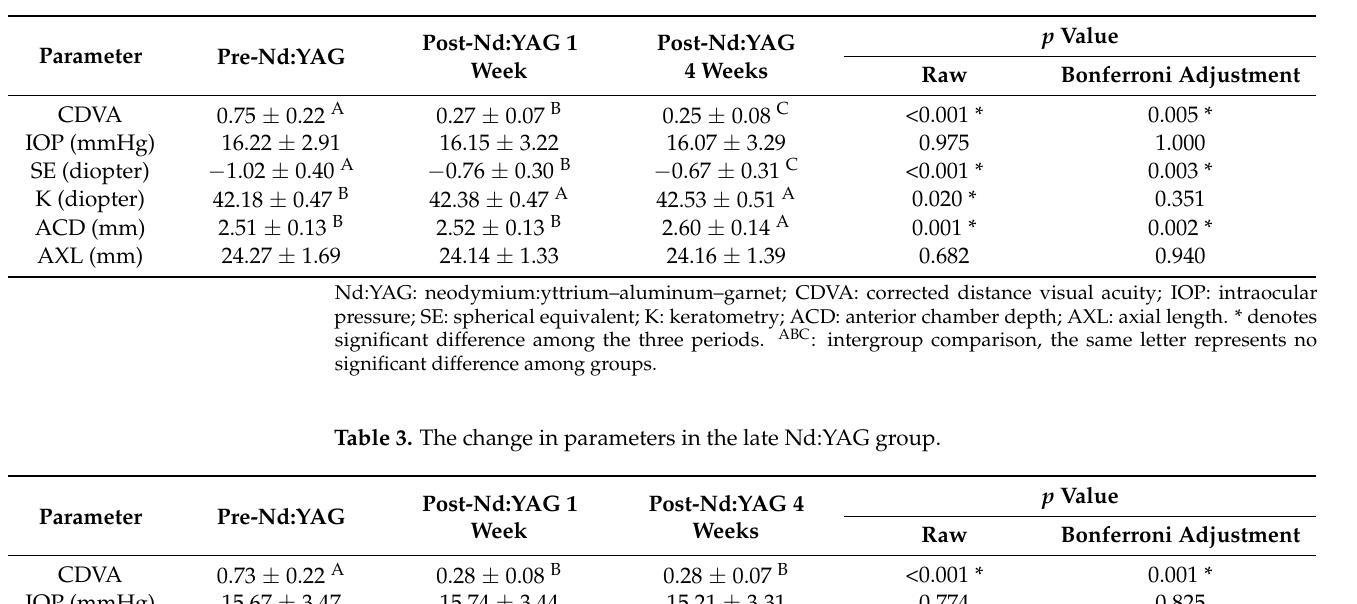
Table 2. Change in parameters in the early Nd:YAG group.